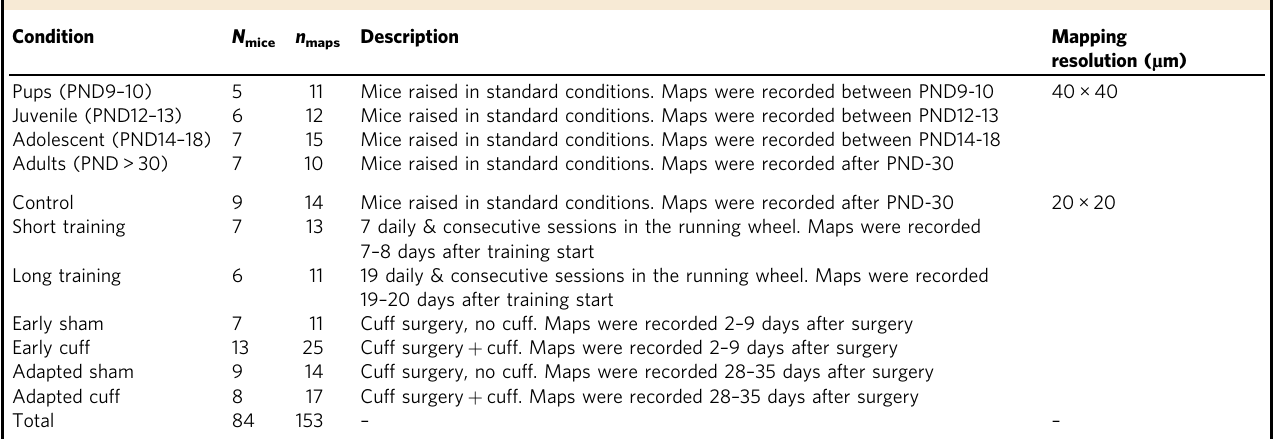
Table 1 Group description and experimental conditions. Condition N mice n maps